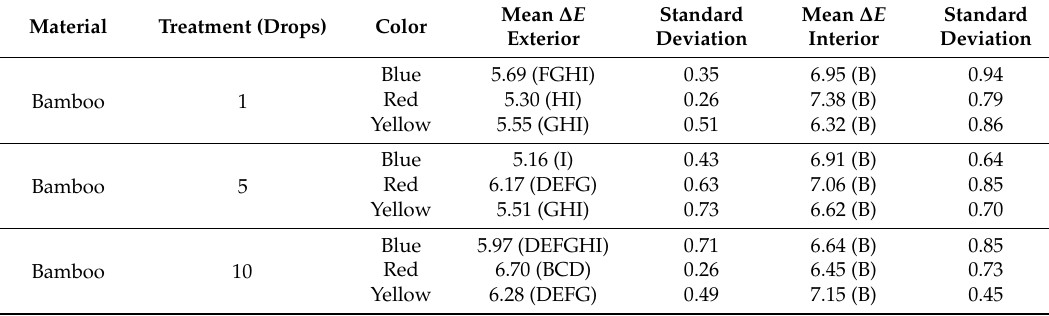
Table 3. Mean ∆ E of the internal and external surfaces of the bamboo blocks for the dripping test. Different letters classify the data as statistically different within each pigment color. DF = 7.